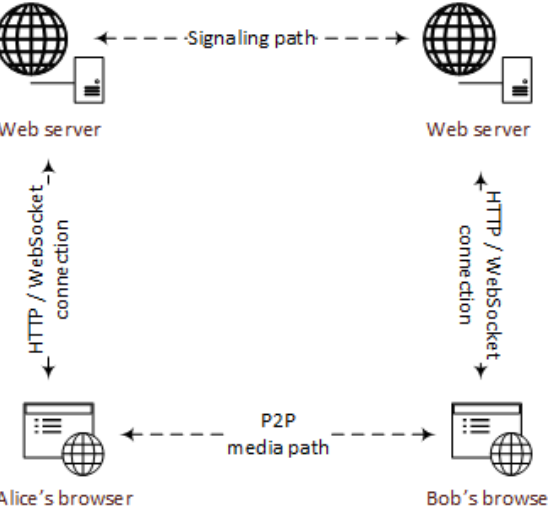
Figure 2. WebRTC trapezoid network architecture.